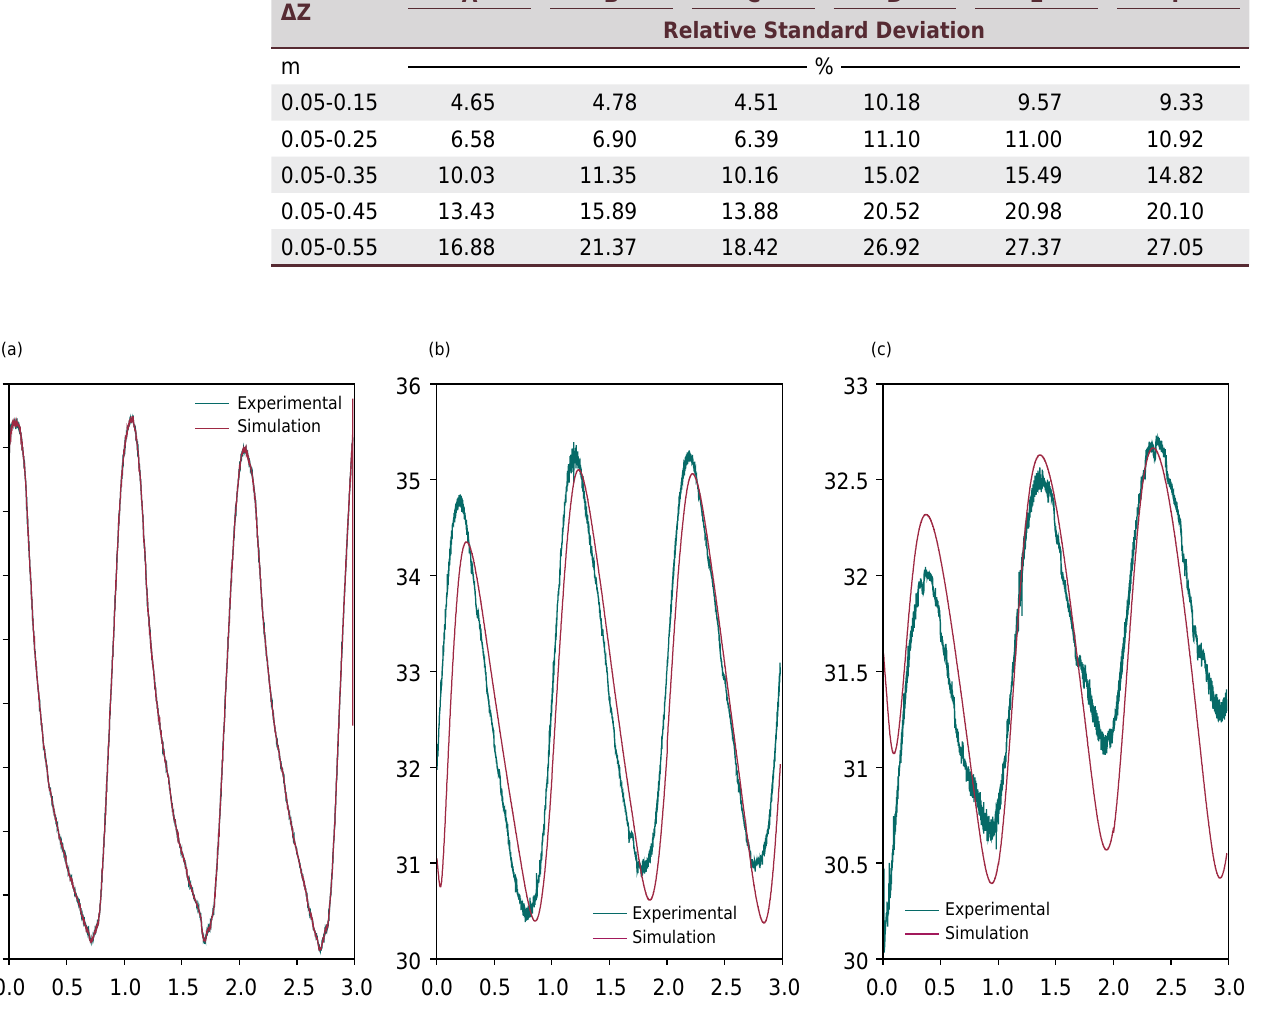
SimulationExperimental